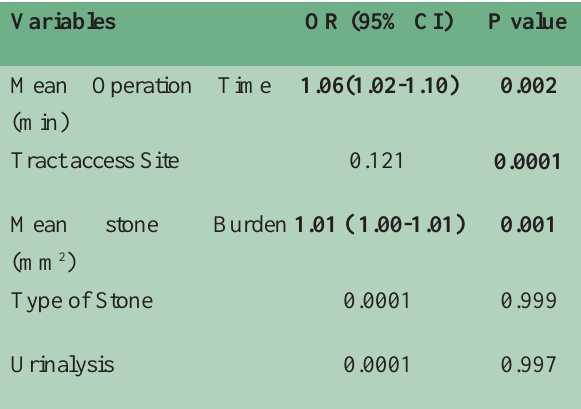
Table 5: Univariate analysis of factors between patients with and without post-operative SIRS Variables